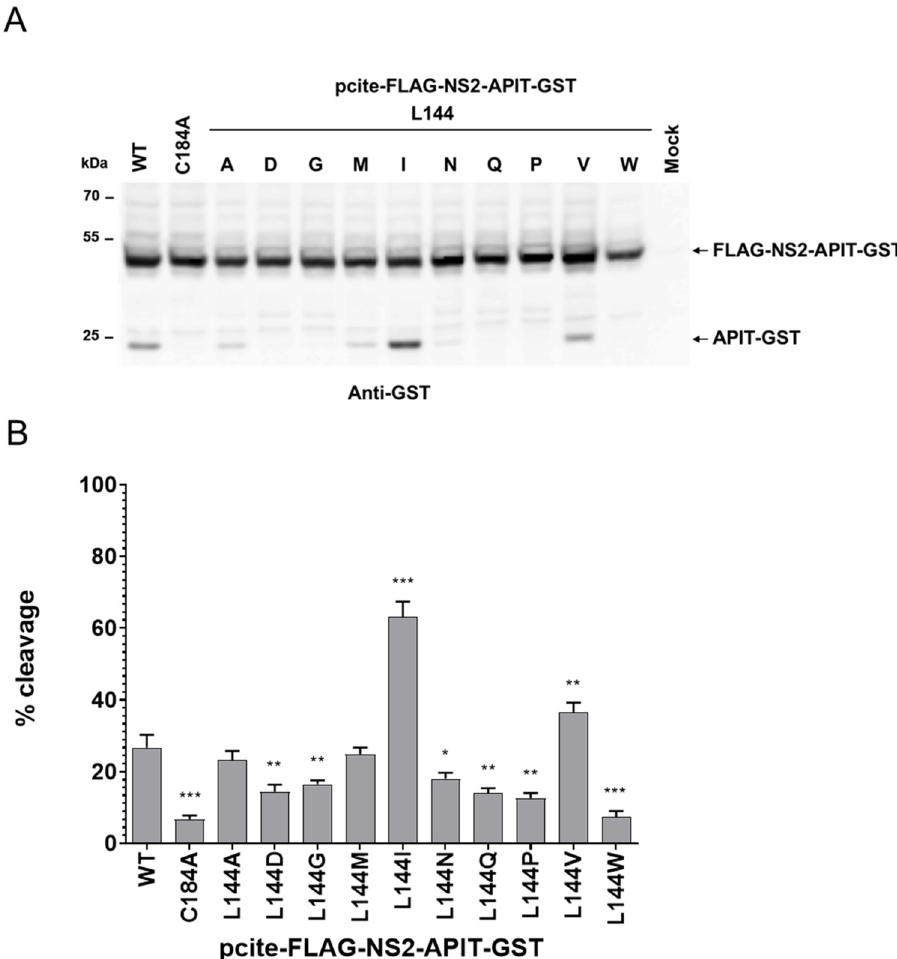
Fig 3. The amino acid exchange L144I is stimulating the intrinsic NS2 pro cleavage efficiency in the absence of the NS3 cofactor. (A) Analysis of the intrinsic NS2 pro activity assay in the MVA/T7 pol expression system in Huh7-T7 cells. NS2-mediated cleavage of FLAG-NS2-APIT-GST/BK was analyzed by Western blotting using GST-specific antibodies. One representative blot from three independent experiments is shown. (B) NS2 pro cleavage efficiencies. Signals of uncleaved FLAG-NS2-APIT-GST and the cleavage product APIT-GST were quantified by ImageJ software from three Western blots to calculate the percentage of NS2-APIT-GST cleavage. Mean and standard deviations of NS2 pro cleavage efficiencies from three independent experiments are presented. Molecular mass standards are shown on the left. Positions of the uncleaved precursor FLAG-NS2-APIT-GST and the cleavage product APIT-GST are indicated on the right. WT: wild-type; mock: transfection control without plasmid DNA. Asterisks indicate statistically significant differences in comparison to WT ( � p < 0.05; �� p < 0.01; ��� p <